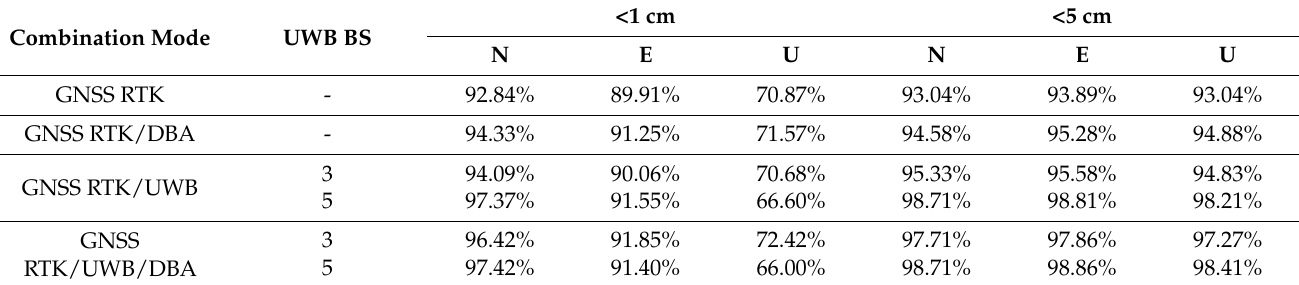
Table 8. Statistics of the GNSS RTK/UWB/DBA fusion positioning model error distribution intervals at a 30 degree elevation mask angle in the dynamic cart scenario.